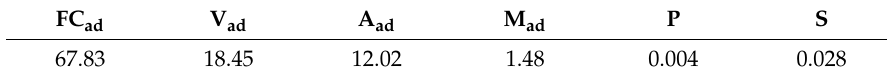
Table 4. Proximate analysis of the coal (mass fraction, %).